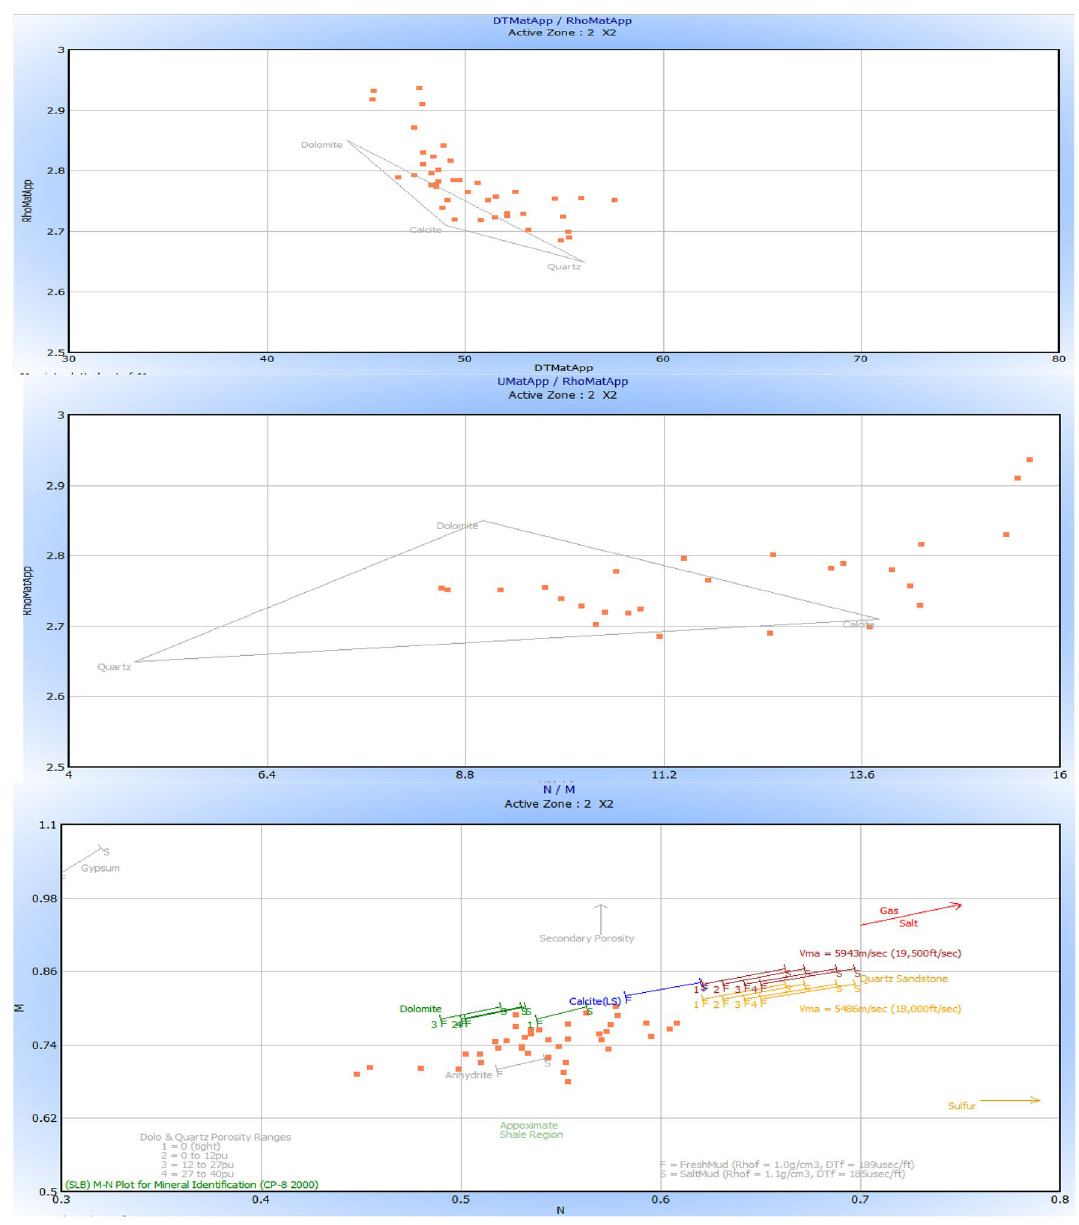
Fig. 13 MID and M–N crossplot Crossplots for mineral identification for reservoir X